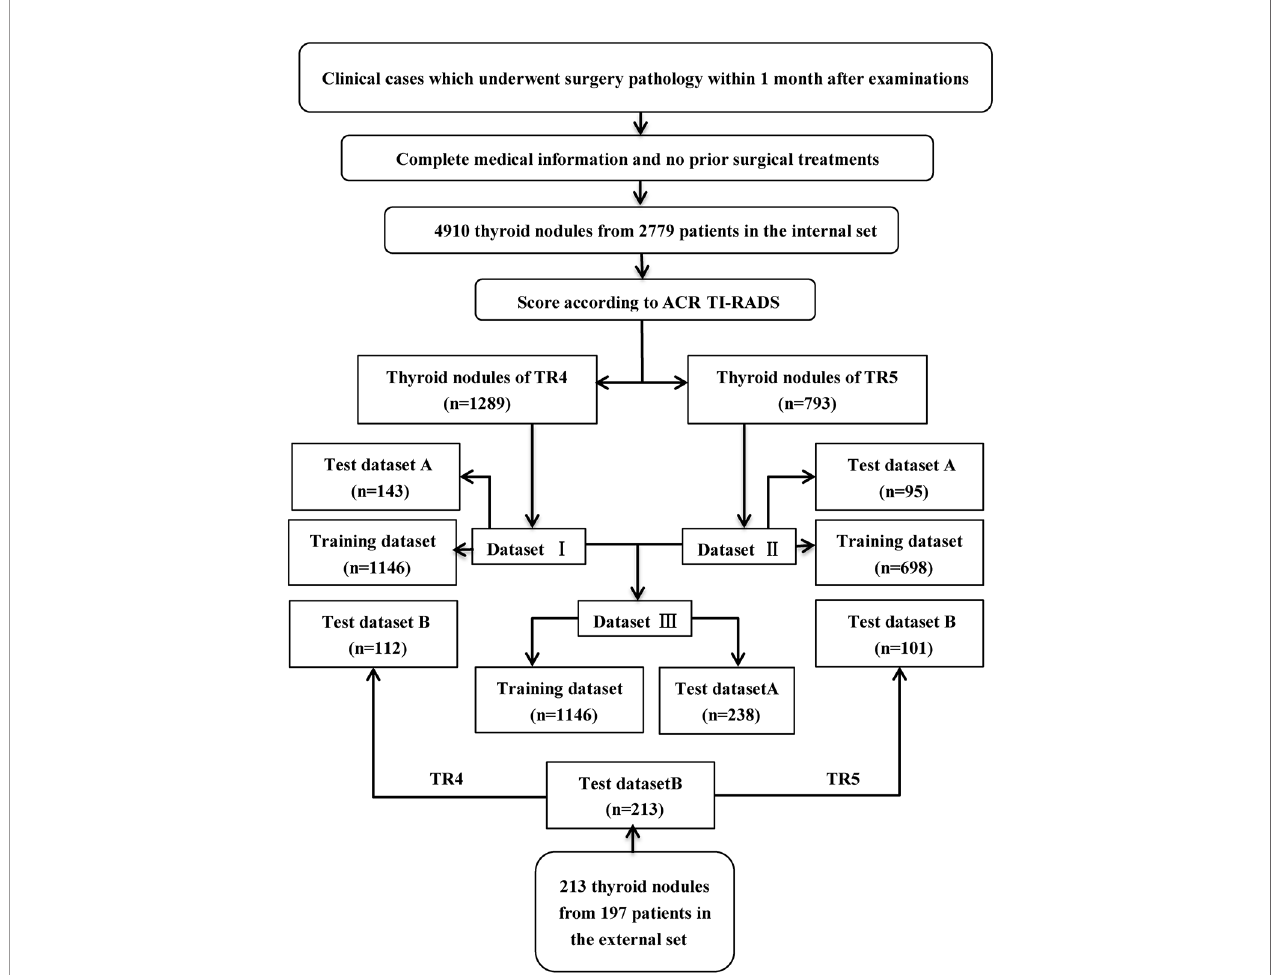
FIGURE 1 | Work fl ow of the construction of the training and test